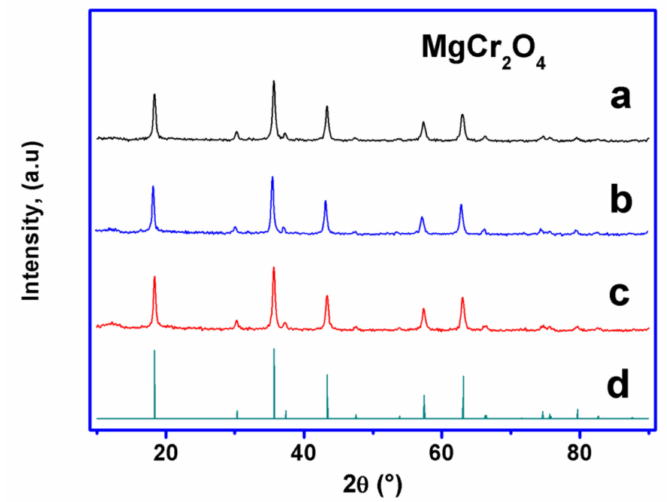
Figure 2. XRD diffractograms of ( a ) MgCr 2 O 4 _HMTA, ( b ) MgCr 2 O 4 _FS, ( c ) MgCr 2 O 4 _TA, and ( d ) reference spectra of MgCr 2 O 4 recorded with Diamond 4